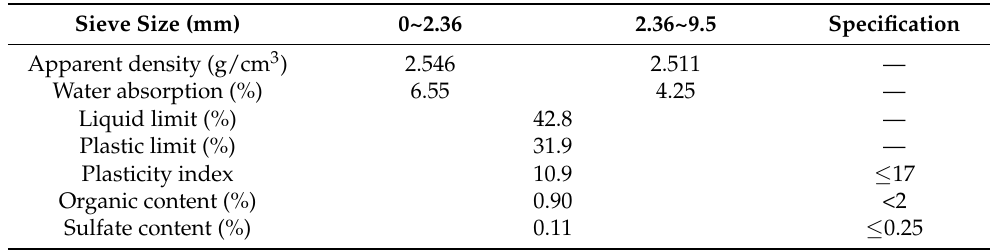
Table 4. Basic properties of bottom